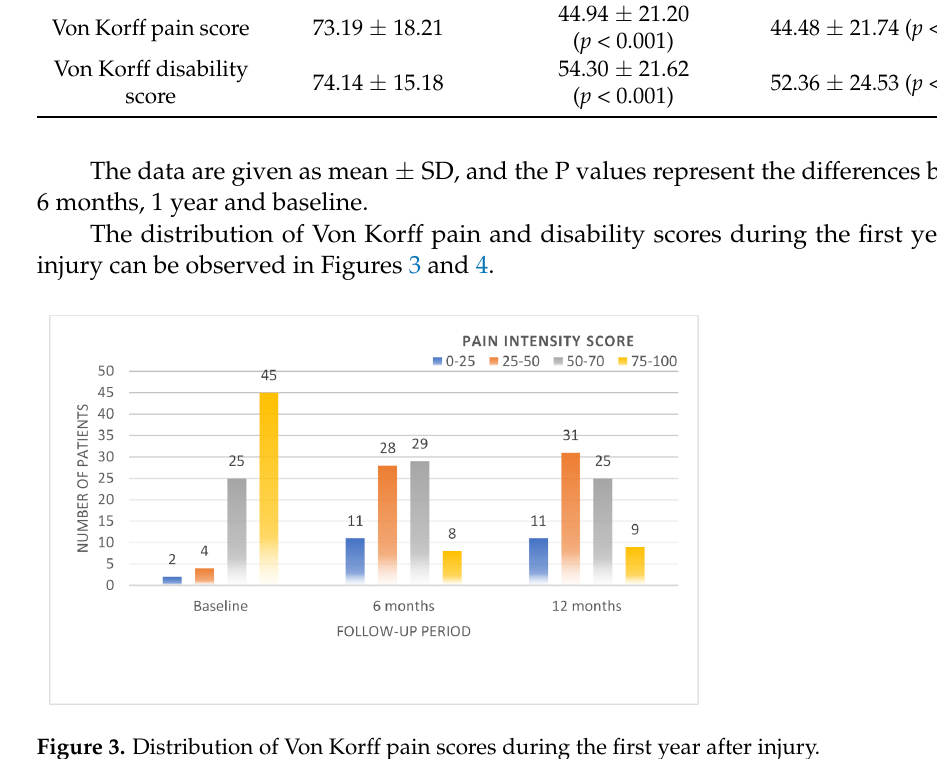
Figure 3. Distribution of Von Korff pain scores during the first year after